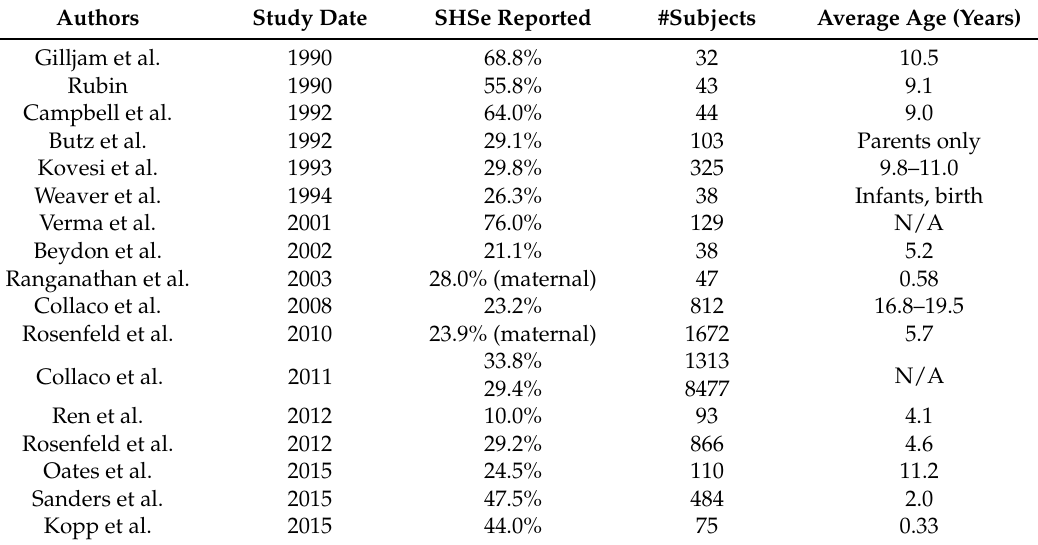
Table 2. Summary of studies with SHS exposure via parental